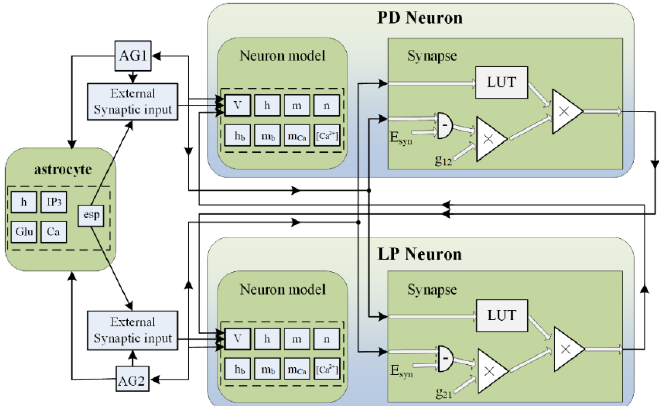
Figure 11. Overall hardware structure of BiSRP-CPG based on FPGA. LP and PD neurons connect with each other through inhibitory synapses. The external synaptic inputs are modulated by both AG signals and the eSP signal from astrocytes for both direct and indirect feedback.